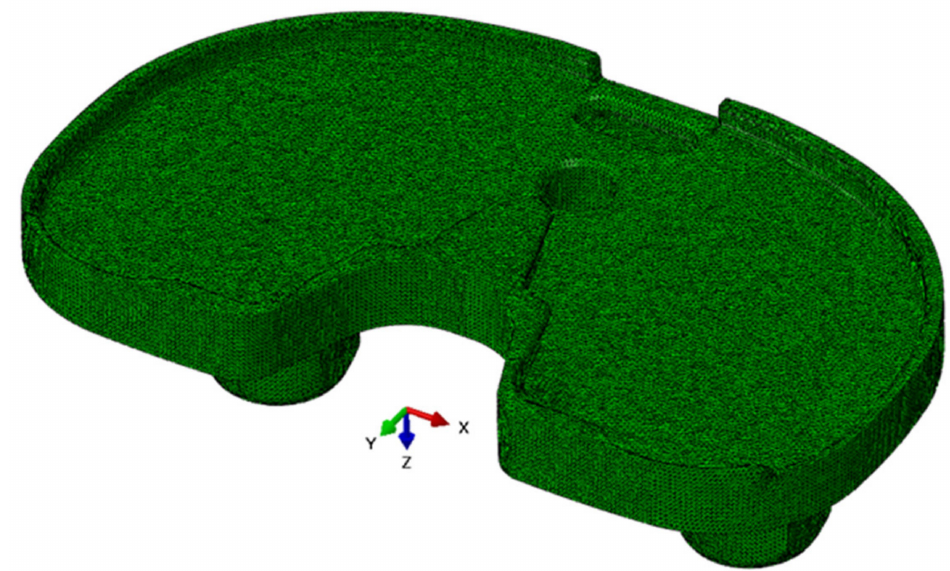
Figure 10. Structural mesh of finite elements of tibial baseplate.